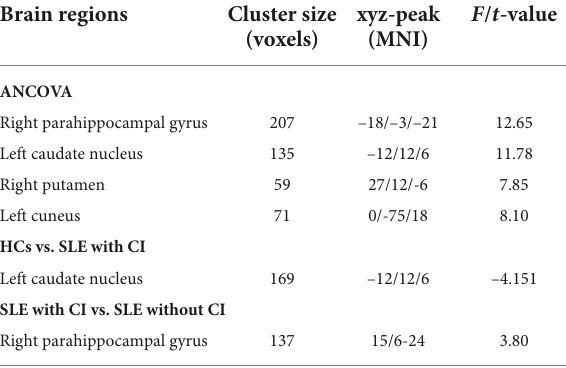
TABLE 2 Regions changes in sALFF in SLE with CI group compared with the SLE without CI and HCs groups. Brain